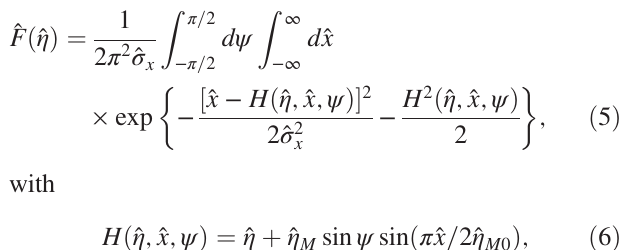
FIG. 3. Plots of the energy distribution function different values of ˆ η M , and (b) ˆ A when ˆ η M = ˆ η M 0 ¼ 1